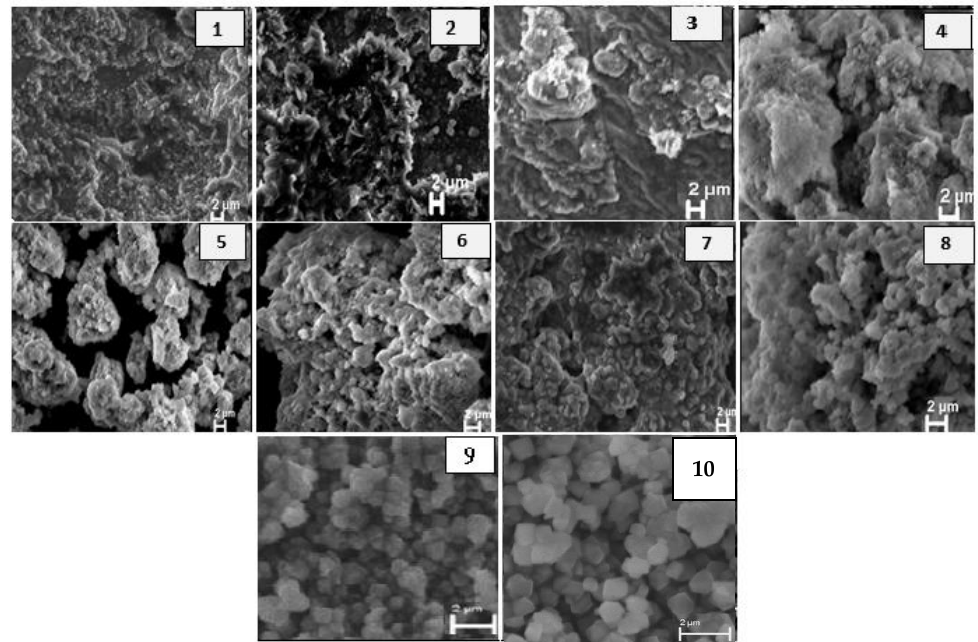
Figure 1. SEM images of lyophilized samples taken out during synthesis of zeolite Y (1–10, according to the Scheme 1).